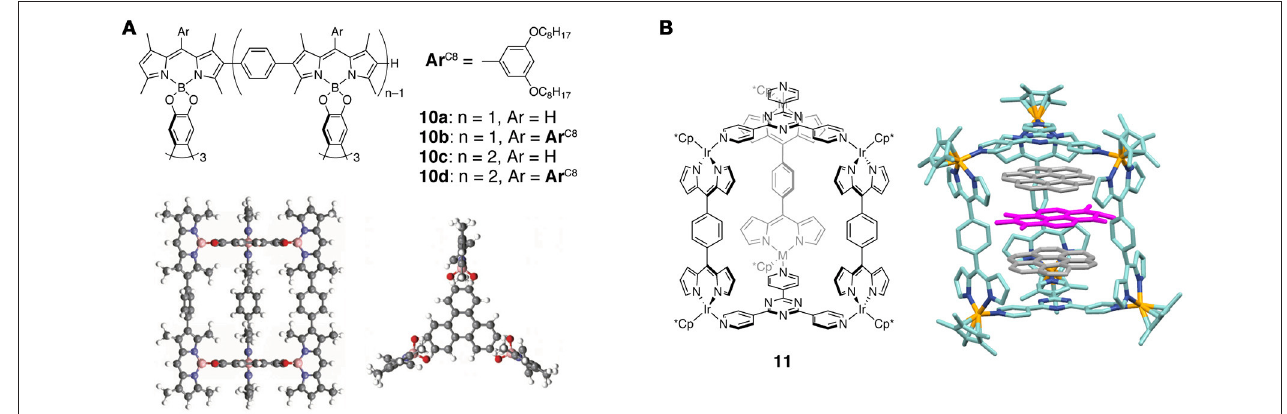
FIGURE 7 | (A) (top) Chemical structures of boron-bridged supramolecular cages 10a – 10d . (bottom) Structure of 10b (side and top view) obtained by AM1 calculations. Adapted with permission from Maeda et al. (2013c). Copyright 2013 The Royal Society of Chemistry. (B) (left) Chemical structure of Ir(III)-bridged supramolecular cage 11 . (right) Structure of multicomponent host-guest complex of 11 , coronenes, and N , N ’-dimethyl-1,4,5,8-naphthalene-tetracarboxylic diimide determined by X-ray crystallography. Hydrogen atoms are omitted for